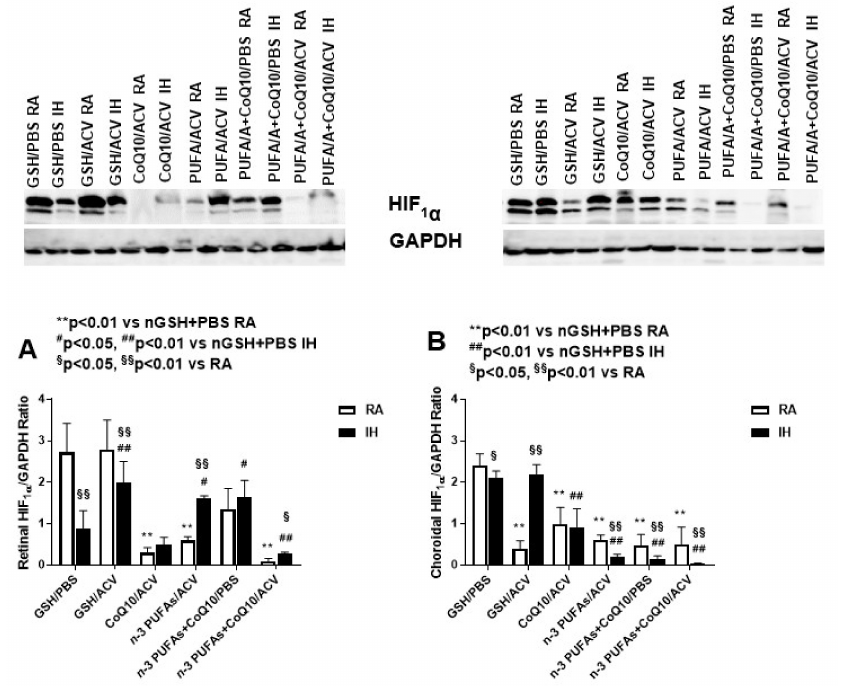
Figure 1. Expression of HIF 1 α in the retina and choroid in response to combination treatments in RA and IH by Western blot analysis. Data are presented as mean ± SEM ratio of HIF 1 α / GAPDH ( n = 4 replicates). Comparison among the RA or IH groups was conducted using one-way ANOVA with Bonferroni post hoc multiple comparisons test. Comparison between RA and IH for each group was conducted using unpaired t -test. Retinal HIF 1 α / GAPDH ratios ( A ), Choroidal HIF 1 α / GAPDH ratios ( B